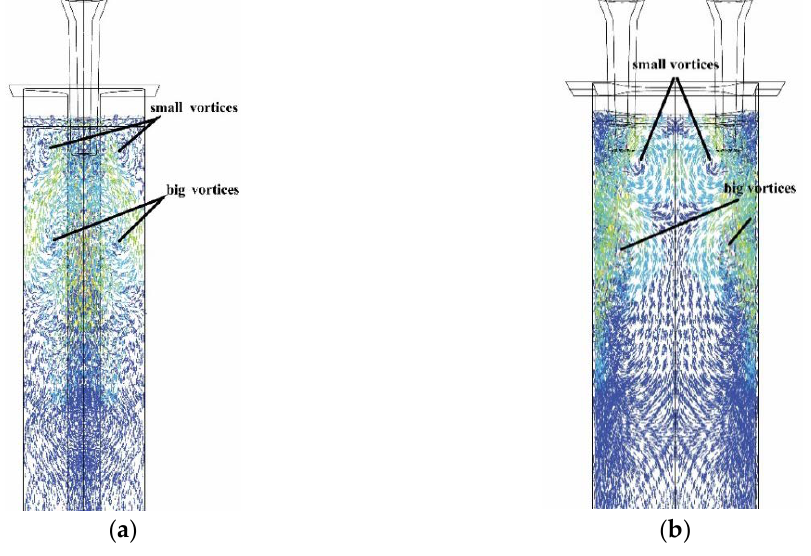
Figure 6. Flow pattern obtained from outside of mold by mathematical modeling: ( a ) narrow face view; ( b ) wide face view.